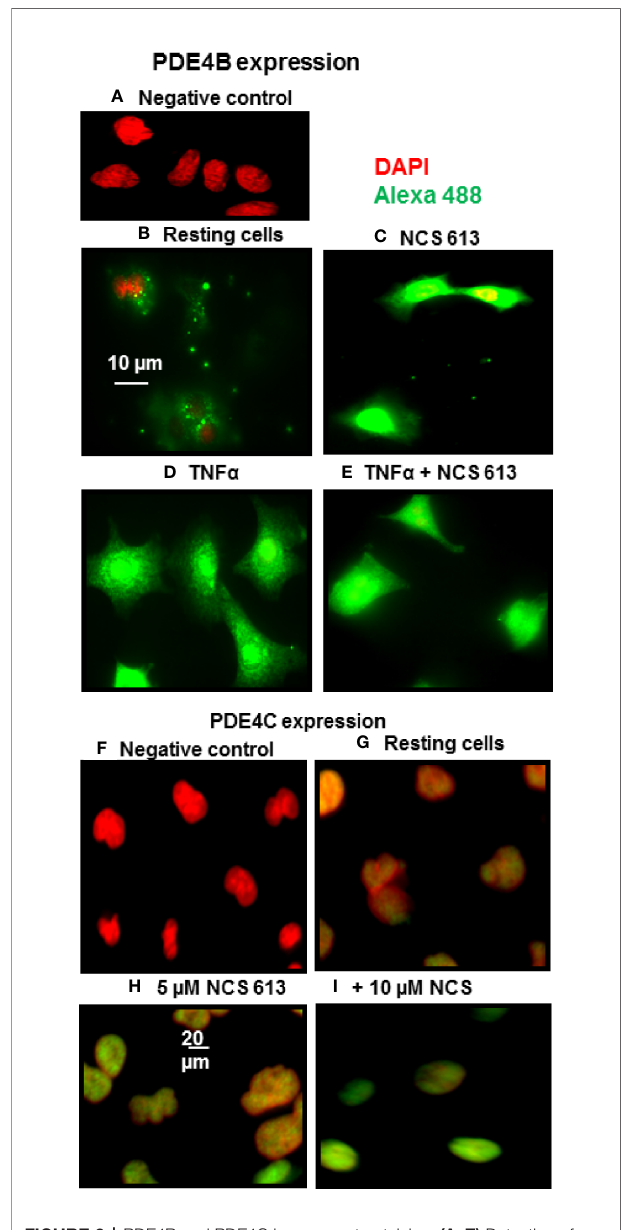
FIGURE 2 | PDE4B and PDE4C immuno-cyto-staining. (A – E) Detection of PDE4B isoforms in A549 cells under control and TNF a treated conditions, in the absence or presence of NCS 613. (A) Negative control showing anti- PDE4B speci fi city; (B) PDE4B basal level in A549 cells; (C) NCS 613 increases PDE4B expression ; (D) TNF a stimulation greatly increases PDE4B expression which is reduce by NCS 613 (E) . (F – I) Detection of PDE4C in A549 cells. (F) Negative control and (G) Basal PDE4C location; (H) and (I) NCS 613 treatments increase nuclear PDE4C in A549 cells. Data are representative of 3 independent experiments. Shown are merged images [x60 (A – E) and x40 (F – I) magni fi cation] of DAPI staining (red) and anti-rabbit-Alexa Fluor 488 (green) recognizing primary anti-PDE4B or anti-PDE4C antibody